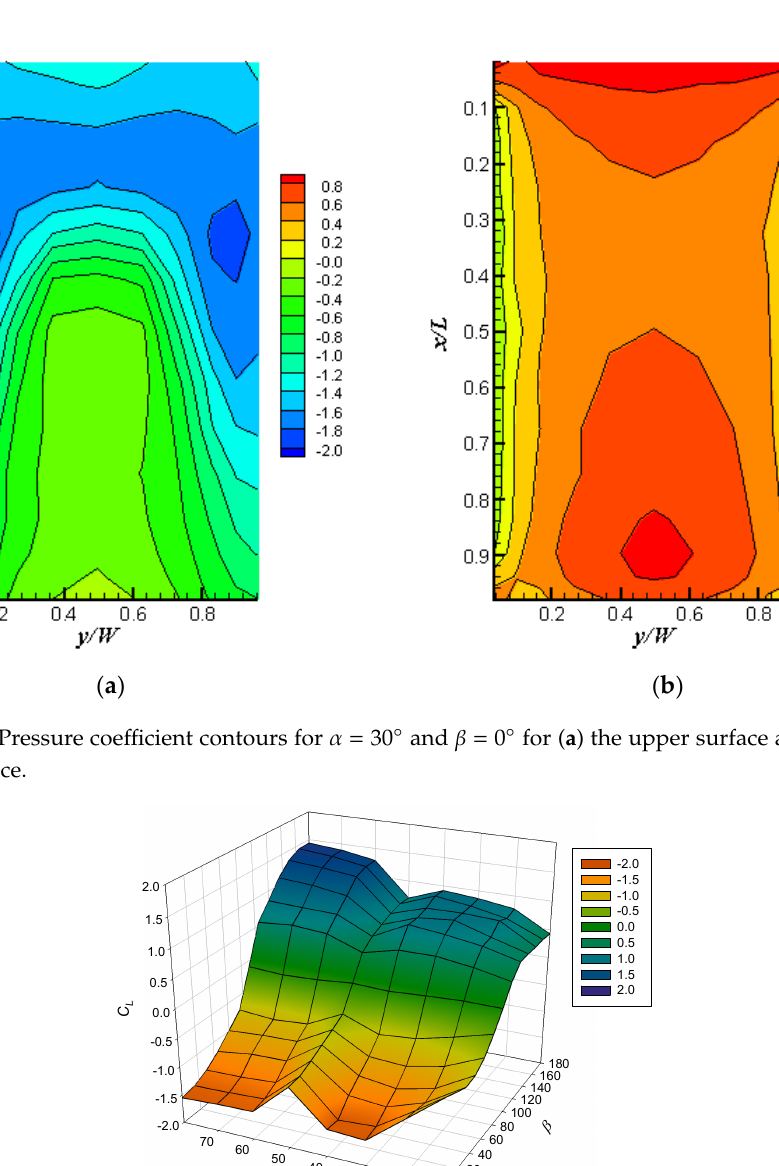
Figure 13. Uplift coefficient for a specific value of β.  0